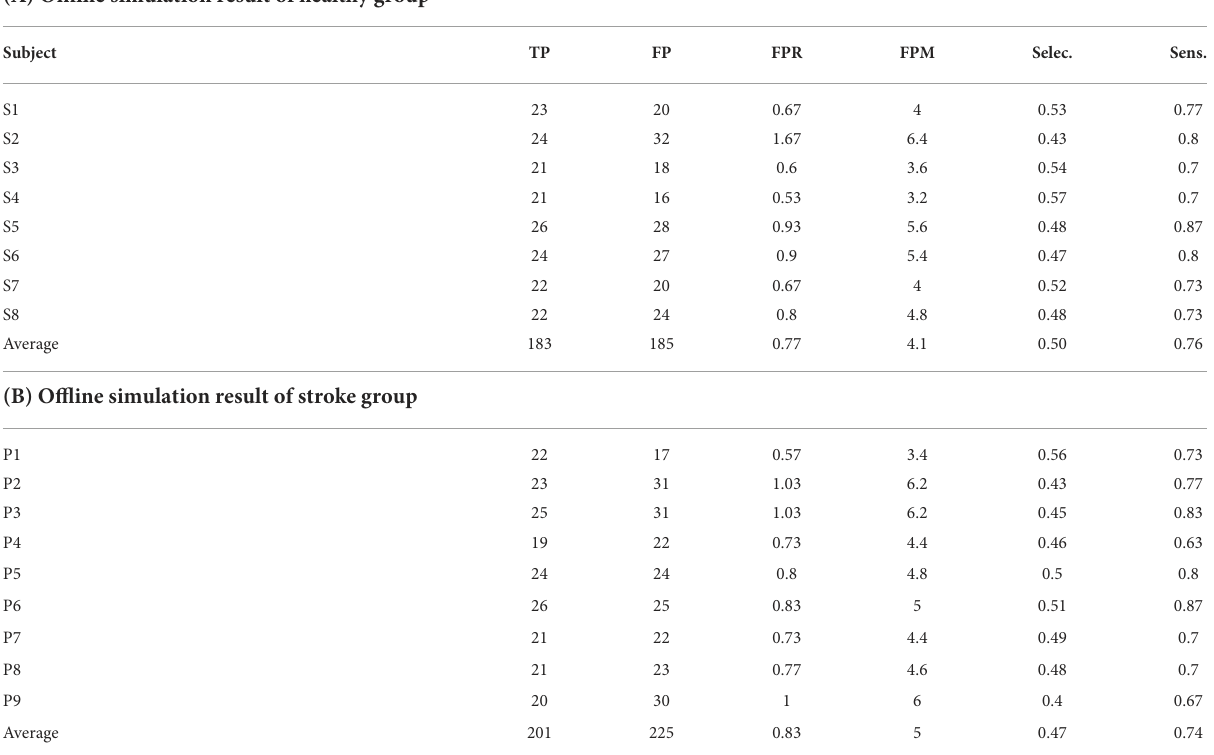
TABLE 4 Performance of the phase 1 classifier in offline